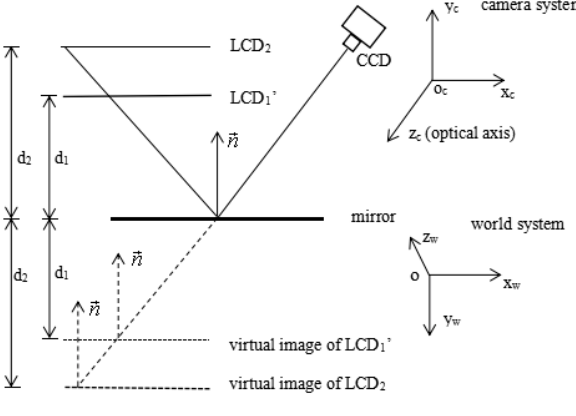
Figure 5. Calculation of d 1 and d 2.